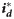
Active current references id* of the inverter control system under load variation.